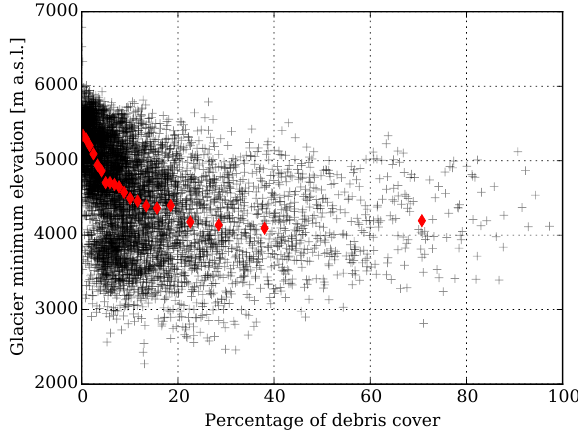
Figure 10. Glacier minimum elevation as a function of the per- centage of debris cover for the glaciers larger than 2km 2 in high- mountain Asia (6571 glaciers in total). The black crosses repre- sent individual glaciers and the red diamonds show the mean of the glacier minimum elevation for each 5th percentile of debris cover. For instance, the first diamond represents the mean of the glacier minimum elevation for glaciers with a percentage of debris cover between 0 (minimum) and 0.51% (5th